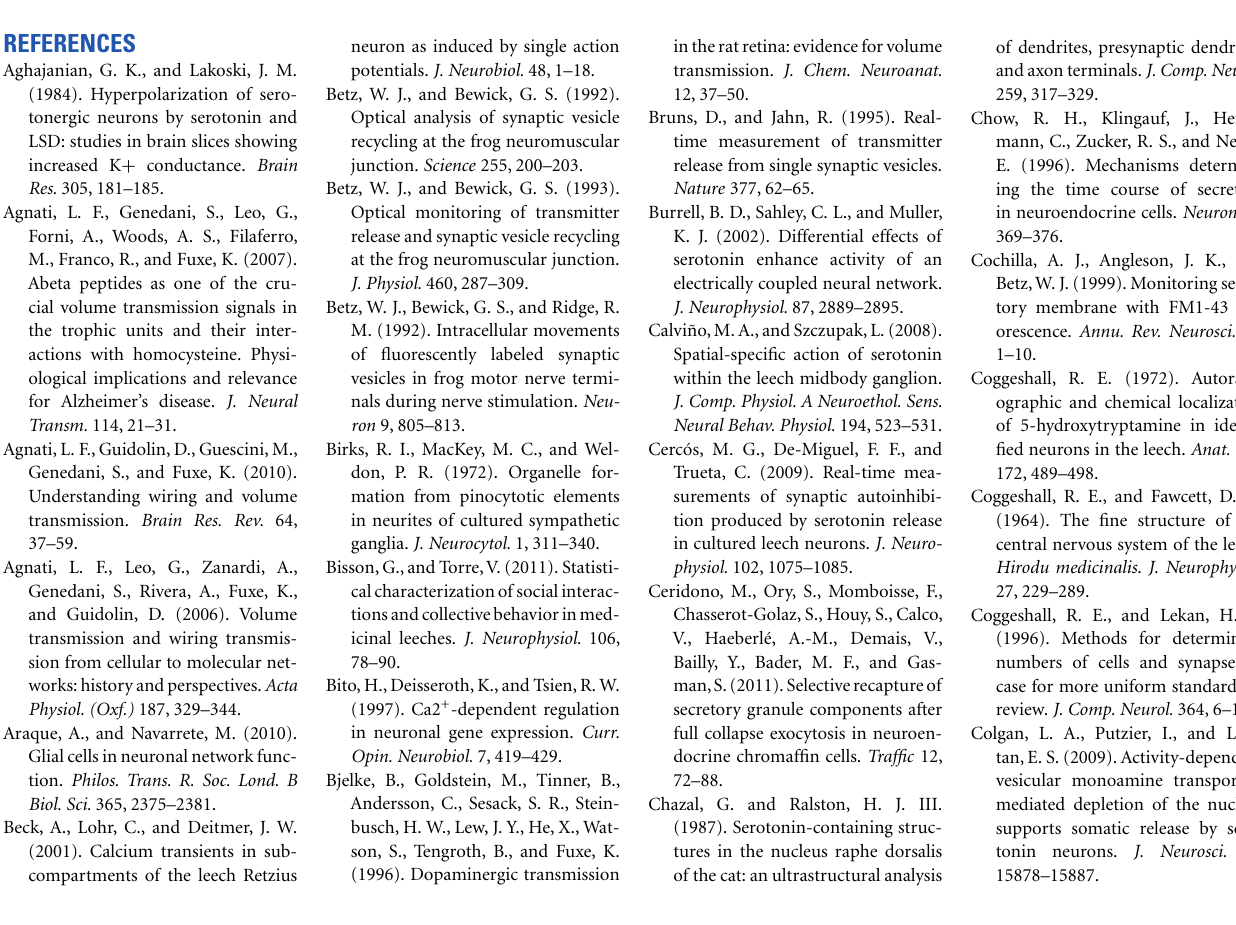
FIGURE 8 | Perinuclear multivesicular bodies. (A) Multivesicular bodies (mvb) coexisting with Golgi apparatus (go).The multivesicular body on the right top contains mostly clear vesicles and is in association with endoplasmic reticulum (er) and mitochondria (m).The one in the right bottom has a membrane discontinuity (arrowhead). On the left side of the image, small